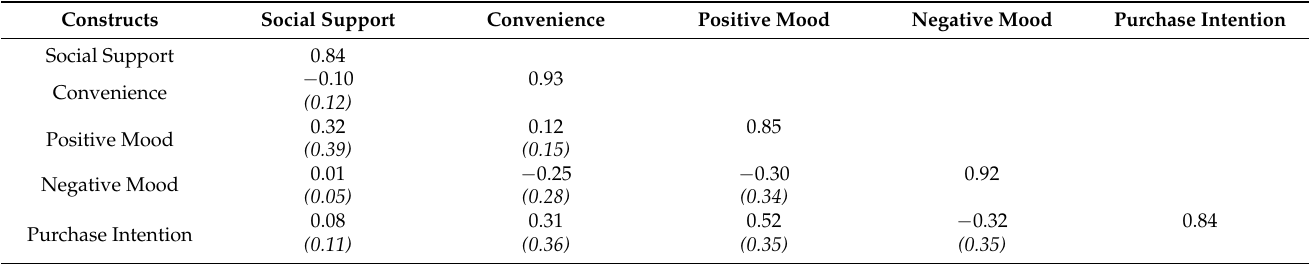
Table A3. Discriminant validity results for Conscientiousness group.